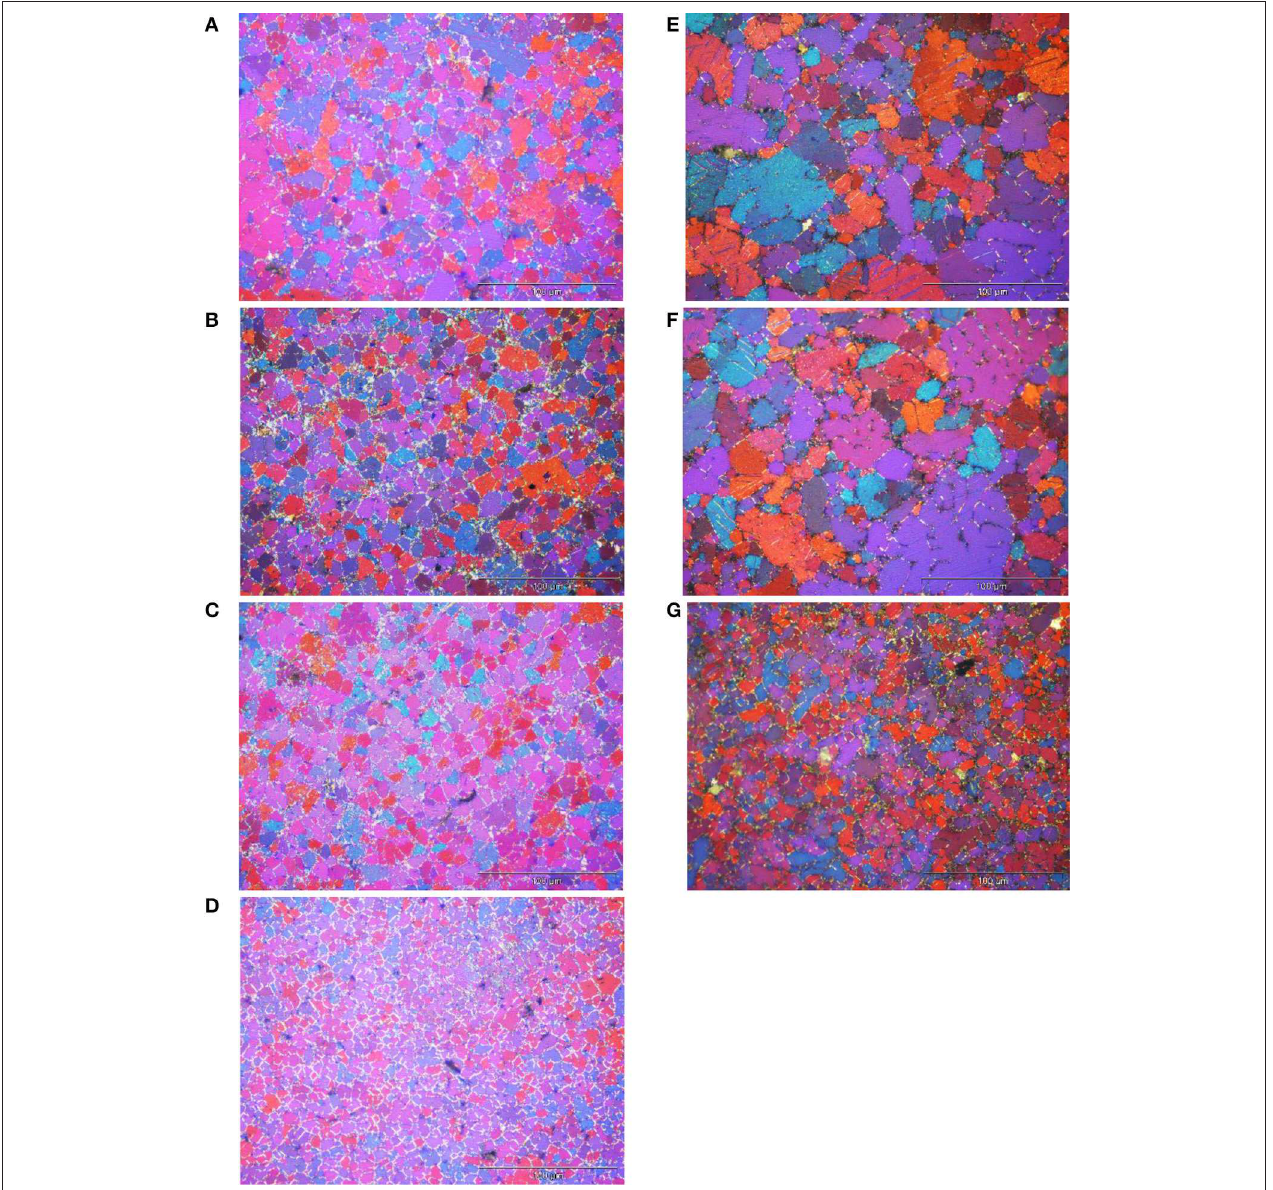
FIGURE 3 | (A–G) Micrographs of as-cast AE42, AE44-2, AE44-4, MRI230D, DieMag211, DieMag422, and DieMag633.